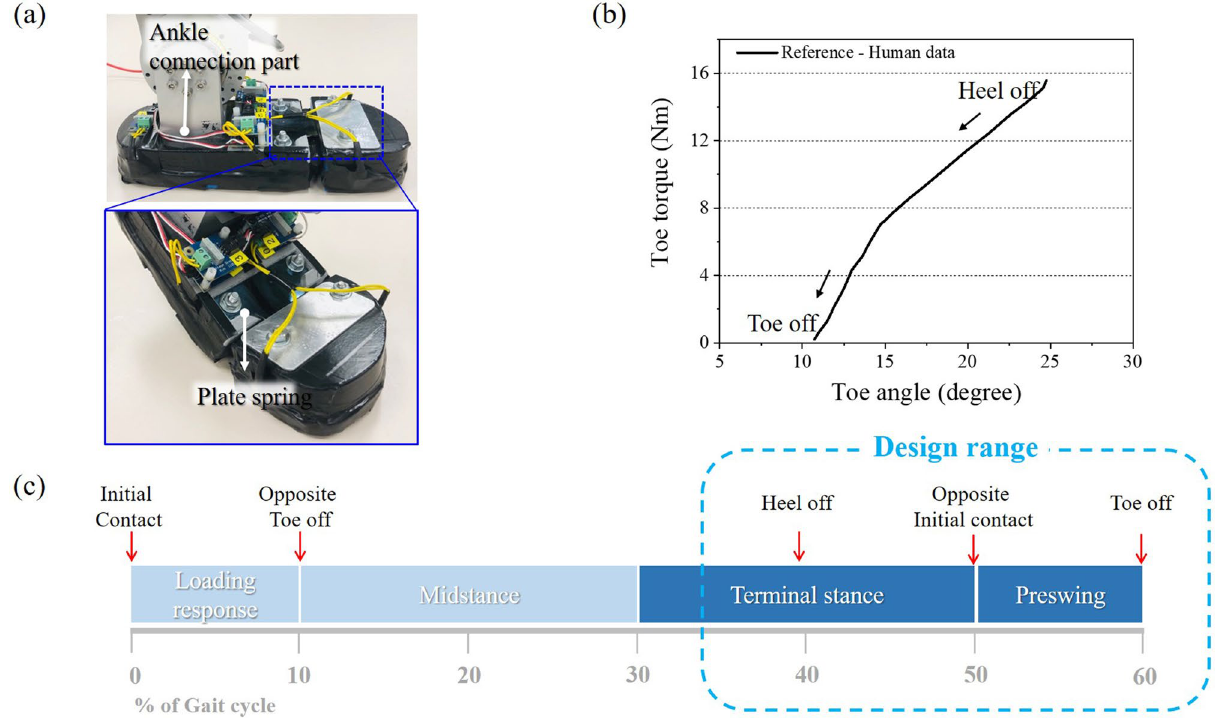
Figure 1. ( a ) A custom-built prosthetic foot which was used in previous study 16,17 ; ( b ) human toe torque vs. angle graph from heel-off to toe-off 18 ; ( c ) target design range of gait cycle in this